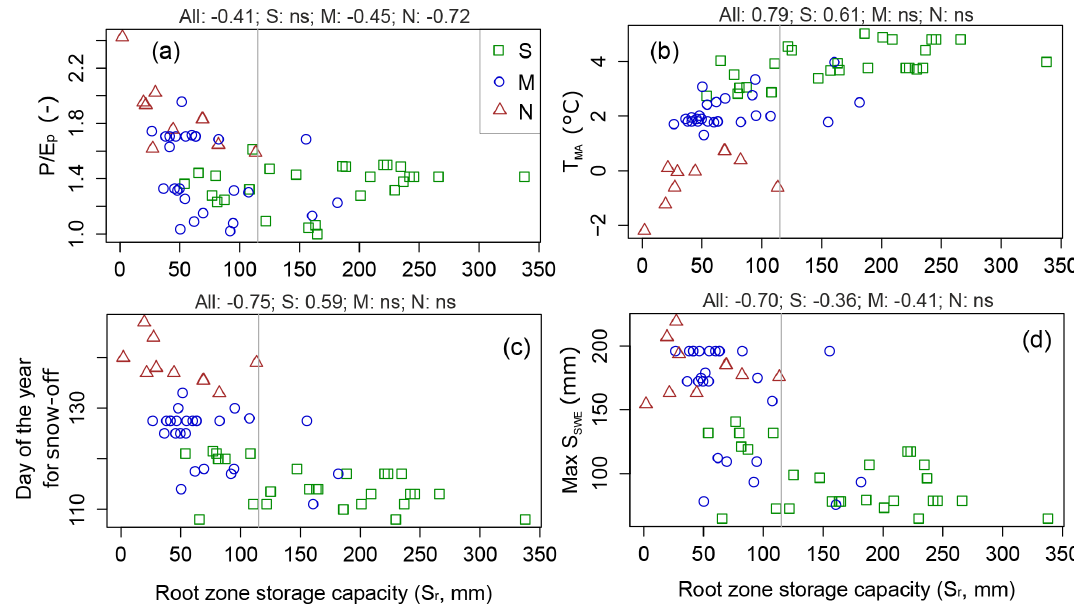
Figure 4. Root zone storage capacities and (a) ratio of average precipitation and potential evaporation ( P/E p ), (b) mean annual temperature ( T MA , ◦ C), (c) day of the year for snow-off, and (d) maximum snow water equivalent ( S SWE , mm) in the catchment at different ecoregions (S is south boreal, M is mid-boreal and N is north boreal). The titles of the sub-plots show the Spearman’s correlation coefficients (significant correlation for p < 0 . 05). The line at 115mm illustrates the discussed